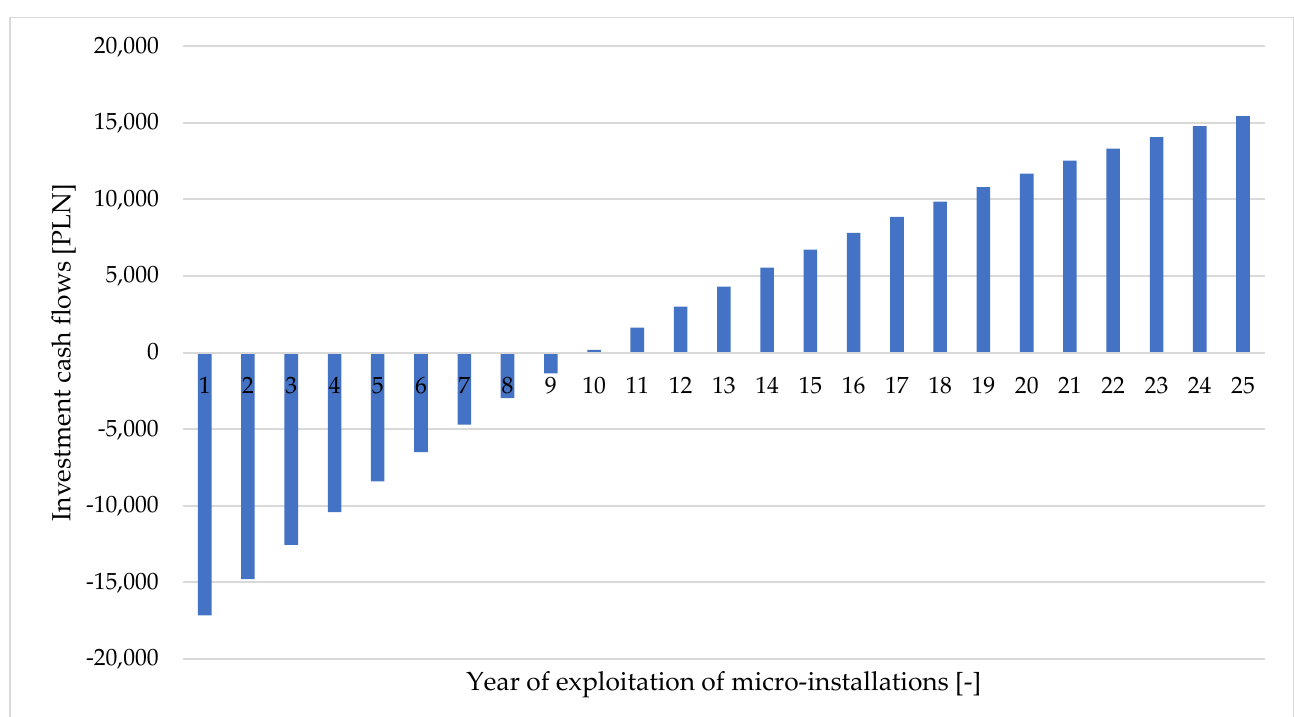
Figure 9. Graph showing the payback period for the capital expenditures incurred in relation to the net-metering system and the 50% self-consumption level.